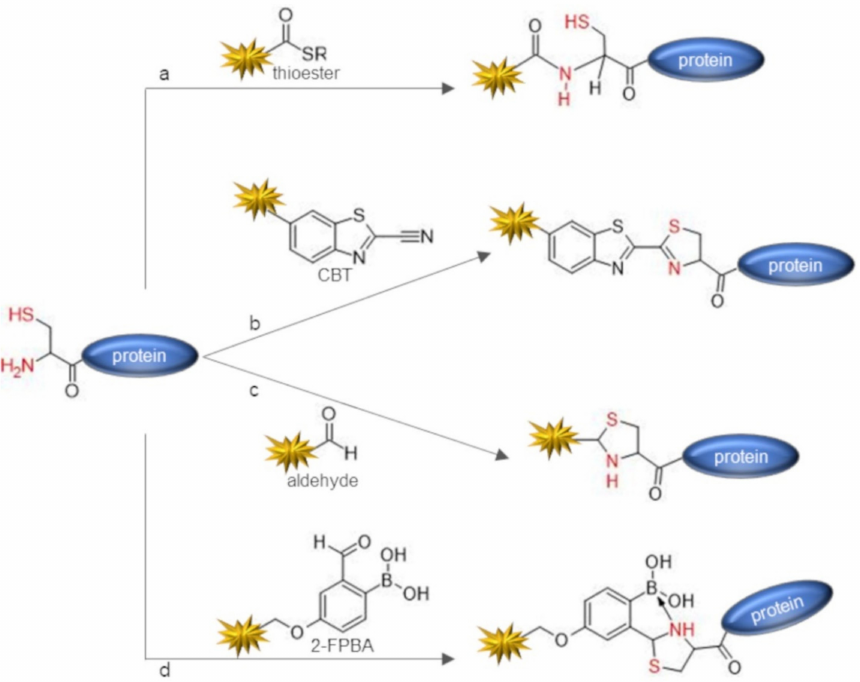
Figure 2. Selective targeting of N-terminal cysteinyl proteins. ( a ) Native chemical ligation with a thioester probe; ( b ) condensation with a 2-cyanobenzothiazole (CBT) probe; ( c ) thiazolidine ligation with an aldehyde probe; ( d ) condensation with a 2-formyl phenylboronic acid (2-FPBA)